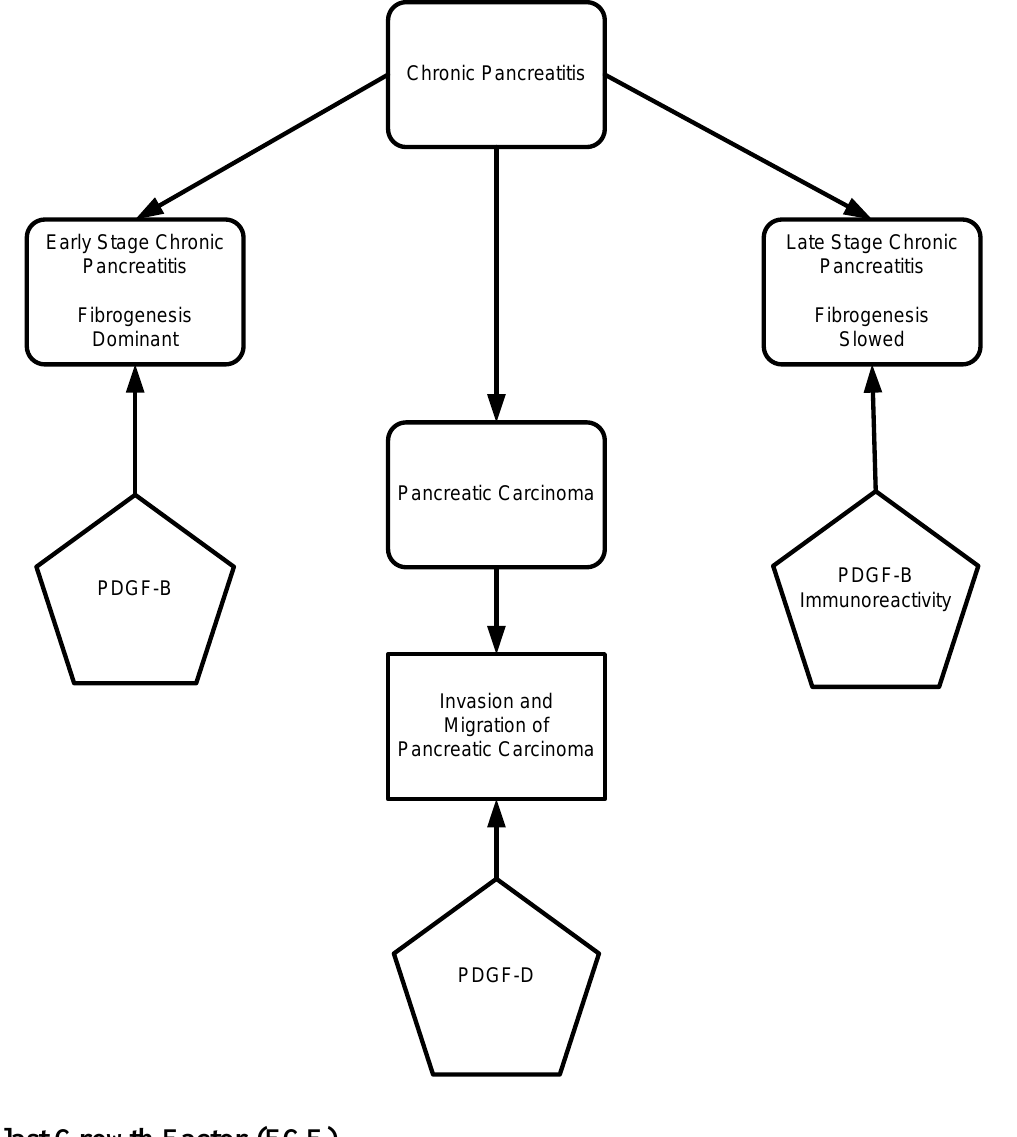
Figure 5. Role of PDGF in formation of pancreatitis, pancreatic carcinoma and progression of